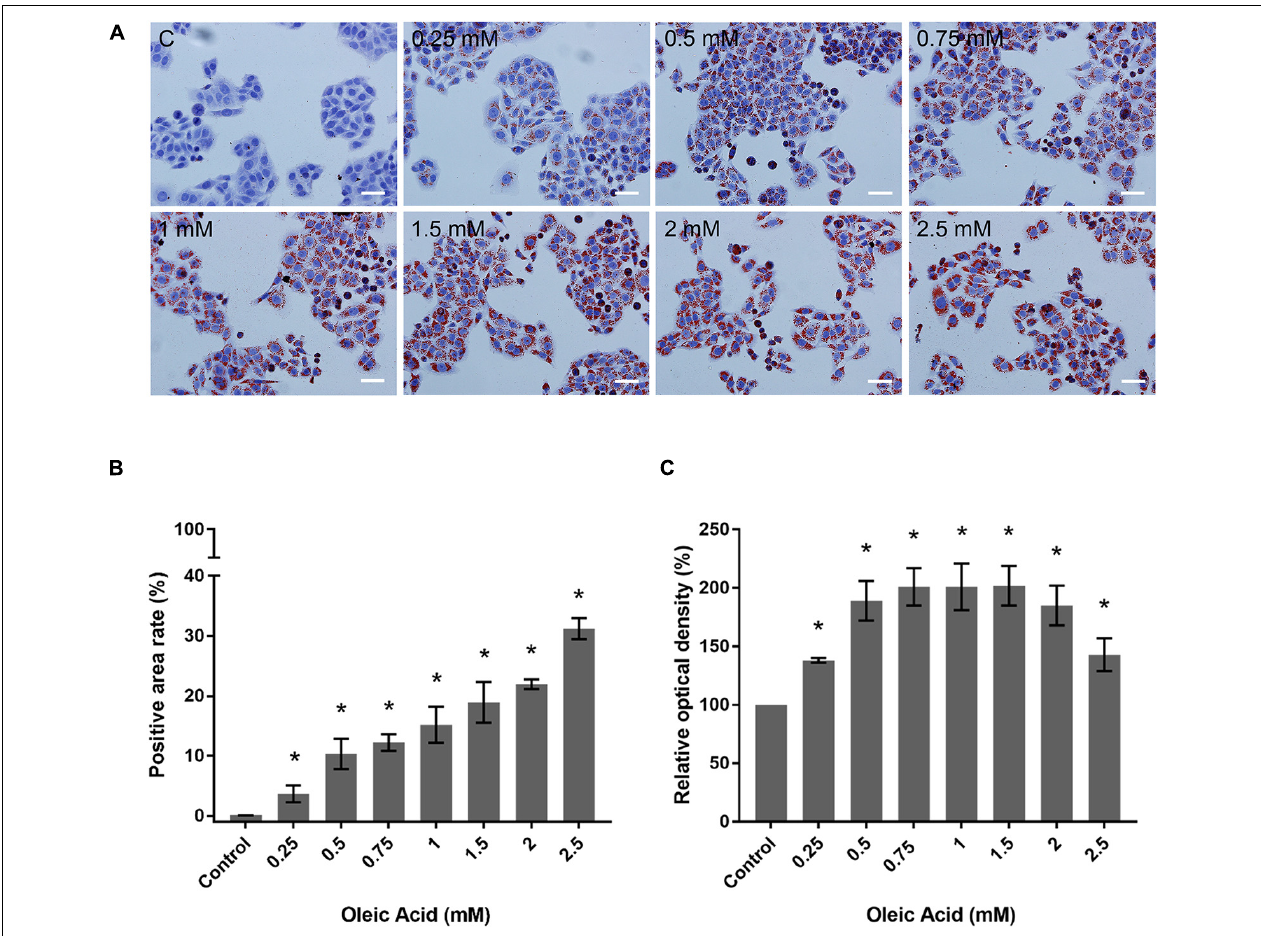
FIGURE 3 | Effects of OA concentration on lipid accumulation in HepG2 cells. (A) ORO staining results of HepG2 cells treated with different concentrations of OA for 24 h. Red staining represents lipids. Images taken at 20 × magnification. Scale bars: 50 µ m. (B) Positive staining area of ORO staining. (C) Extent of ORO staining quantified by spectrophotometry. Experiments were performed in triplicates in three independent experiments. * p < 0.05, compared with the control